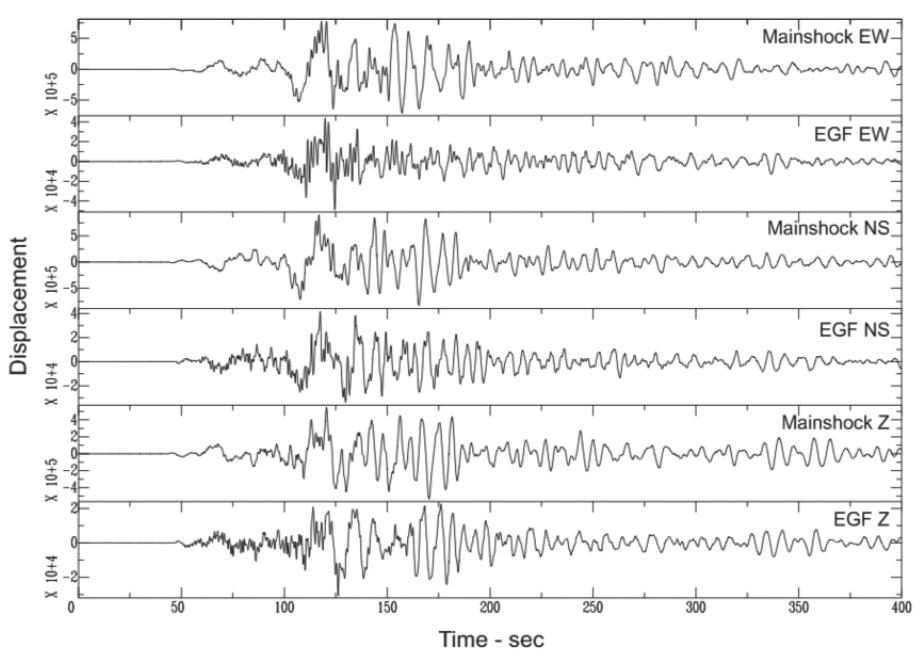
Figure 2. Comparison of the eGF displacement waveforms with the corresponding studied mainshock waveforms for the three components (top, EW; middle, NS; bottom, Z) of station AQU. All of the waveforms were bandpass filtered in the frequency range 0.01 Hz to 1 Hz.